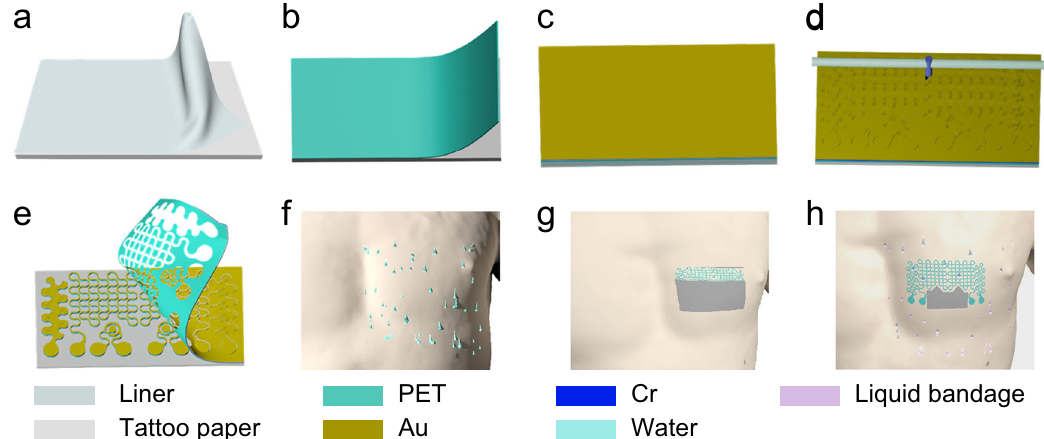
Fig. 1 Schematics of the cut-and-paste manufacturing processes for ultra-thin, tape-free e-tattoo. a Removing the liner from commercial tattoo paper. b Laminating 1.4- μ m-thick transparent PET sheet on the tattoo paper. c Depositing 10-nm-thick Cr and 100-nm-thick Au on the PET with thermal evaporator. d Patterning the Au/Cr/PET sheet with a commercial cutter plotter. e Peeling off the extraneous parts from the tattoo paper. f Applying little water on human skin. g Pasting e-tattoo on human skin from tattoo paper. h Spraying liquid bandage over the e- tattoo with the hydration sensors being covered by a